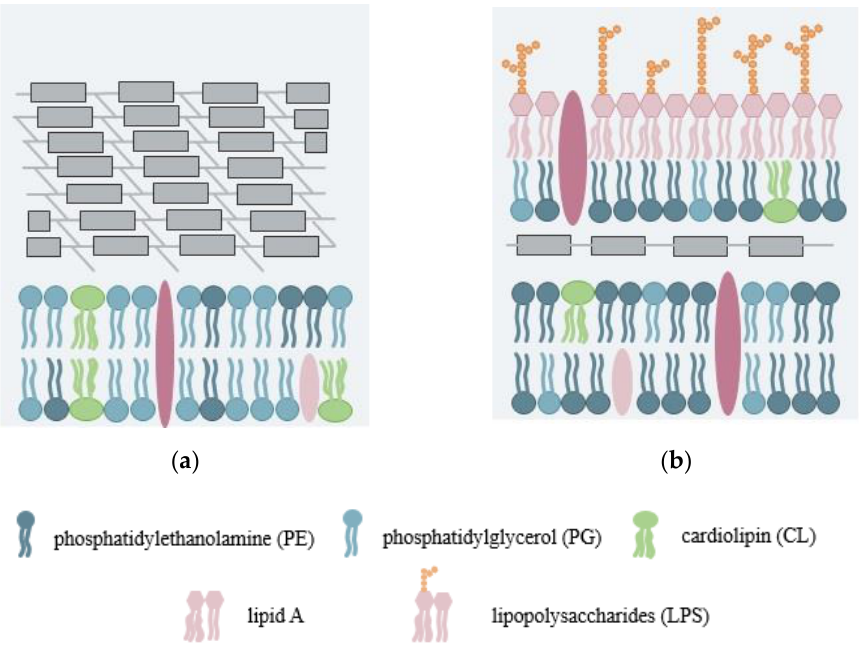
Figure 1. A schematic representation of ( a ) Gram-positive and ( b ) Gram-negative bacterial membranes.